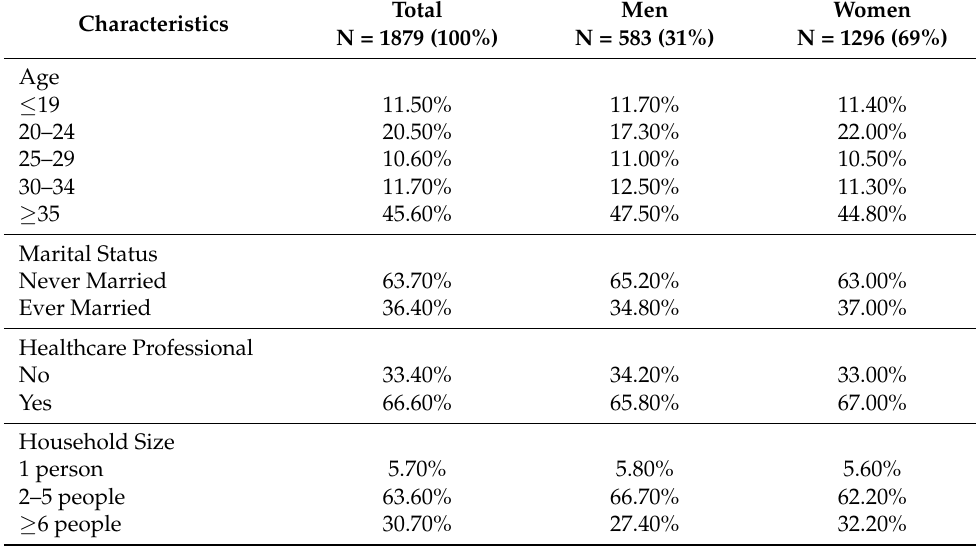
Table 1. Participant